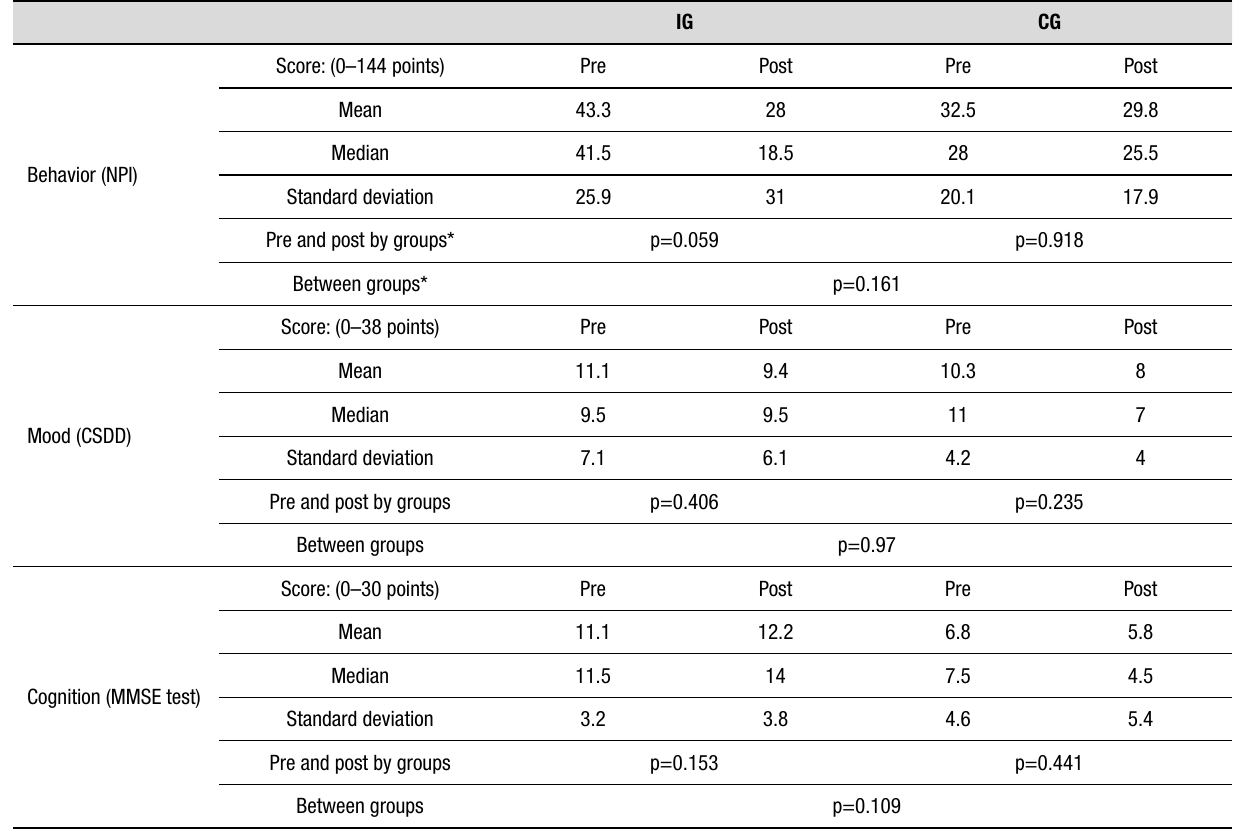
Table 2. Effects on behavior, changes in mood, and cognitive capacity of both groups in the pre- and post-intervention period. IG CG